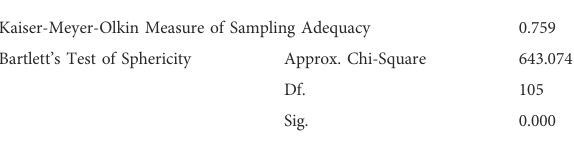
TABLE 4 Kaiser maier olkin and Bartlett ’ s test. KMO and bartletts